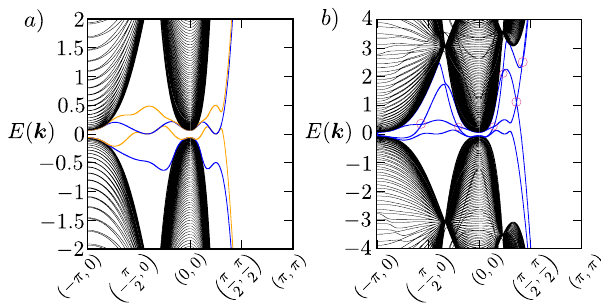
Fig. 4 Effects of surface perturbations on the multiplicative Hopf insulator phase. a Slab spectrum for the multiplicative Hopf insulator along high-symmetry lines in the surface Brillouin zone with hard boundary perturbation term H μ , where here μ = 0.5 and m = 1.5. The four middle bands in energy that were two-fold degenerate for μ = 0, highlighted by dashed orange and blue lines in Fig. 3d, are here highlighted alternatingly in blue and orange to emphasize the breaking of this two-fold degeneracy and the gapping out of one pair of the gapless boundary states to become topologically trivial, while the other pair remains topologically protected, and b slab spectrum for the multiplicative Hopf insulator along high- symmetry lines in the surface Brillouin zone with soft, or adiabatic, boundary perturbation term H α ;‘ , with Zeeman fi eld strength α = 0.05 and number of slab layers over which the boundary perturbation increases ℓ = 4, with m = 1.5. The four middle bands in energy are highlighted in blue with two-fold degeneracies highlighted by pink circles. Each dispersion here is for a slab calculation with N = 80 layers and the step size in k -space is